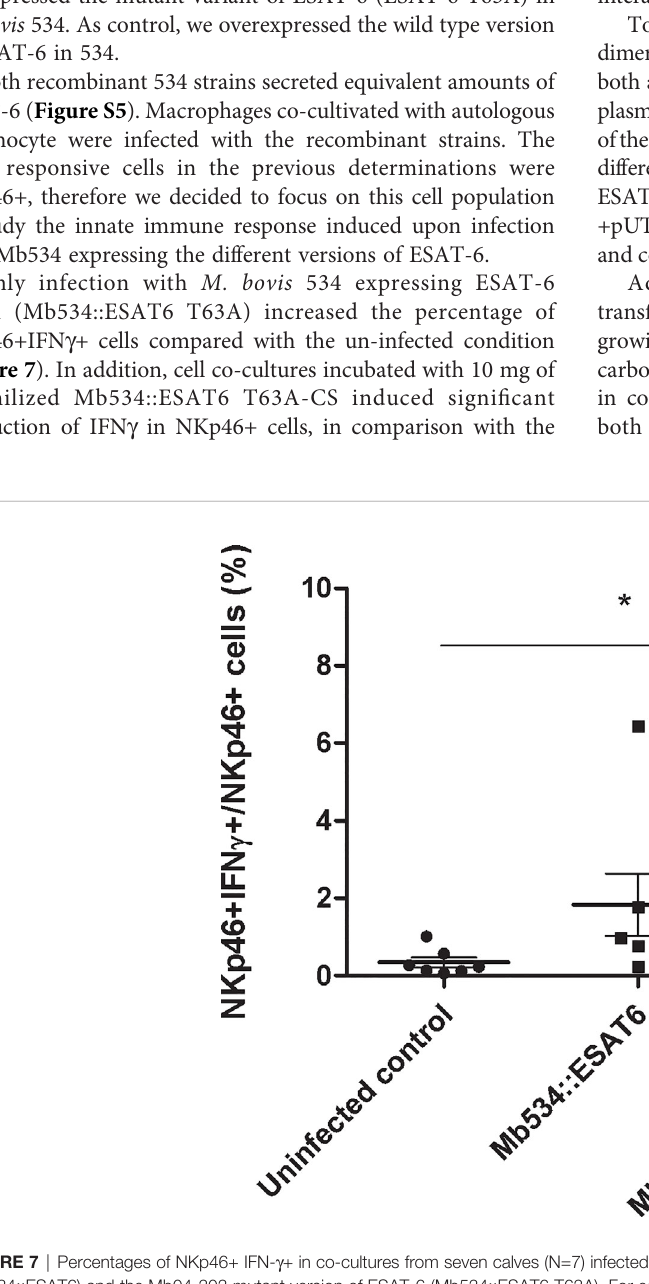
FIGURE 7 | Percentages of NKp46+ IFN- g + in co-cultures from seven calves (N=7) infected with the recombinant versions of Mb534 expressing wild type ESAT-6 (Mb534::ESAT6) and the Mb04-303 mutant version of ESAT-6 (Mb534::ESAT6 T63A). For each animal sample and condition tested, a single cell well was analyzed. Each symbol represents an individual animal; horizontal lines represent mean values and whiskers SEM. The results are expressed as IFN- g + cells in total NKp46+ population (*signi fi cant differences p < 0.05 by Friedman test with Dunn ’ s post-test for multiple